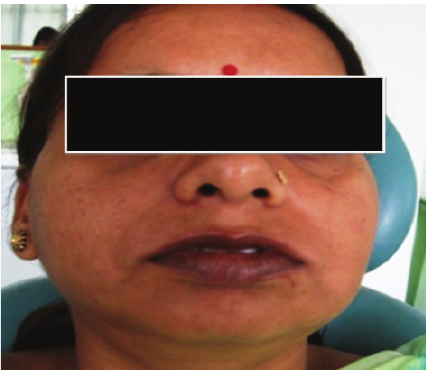
Table 1: Syndromes associated with gingival fibromatosis [6].